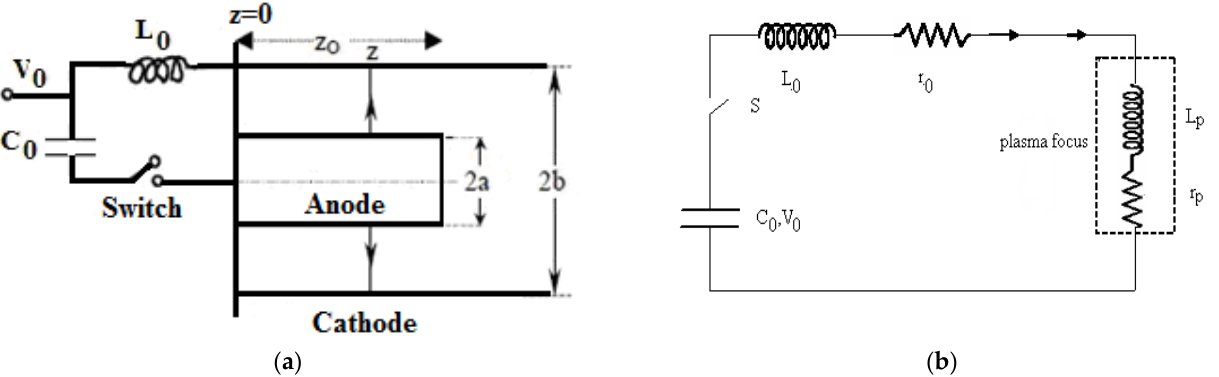
Figure 1. ( a ) The major parts of plasma focus device. ( b ) Equivalent electrical circuit of the plasma focus device, where L p and r p are the inductance and resistance of the plasma,